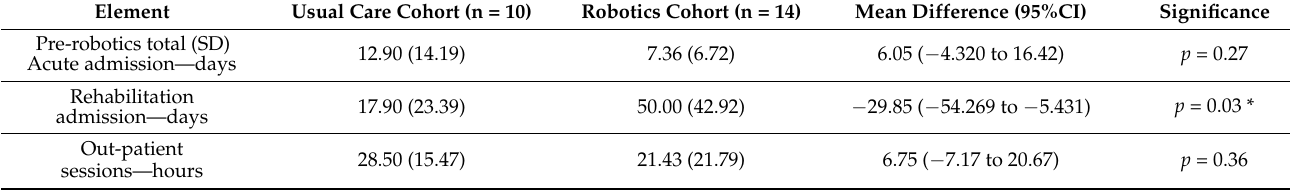
Table 6. Baseline health service and out-patient therapy utilisation.